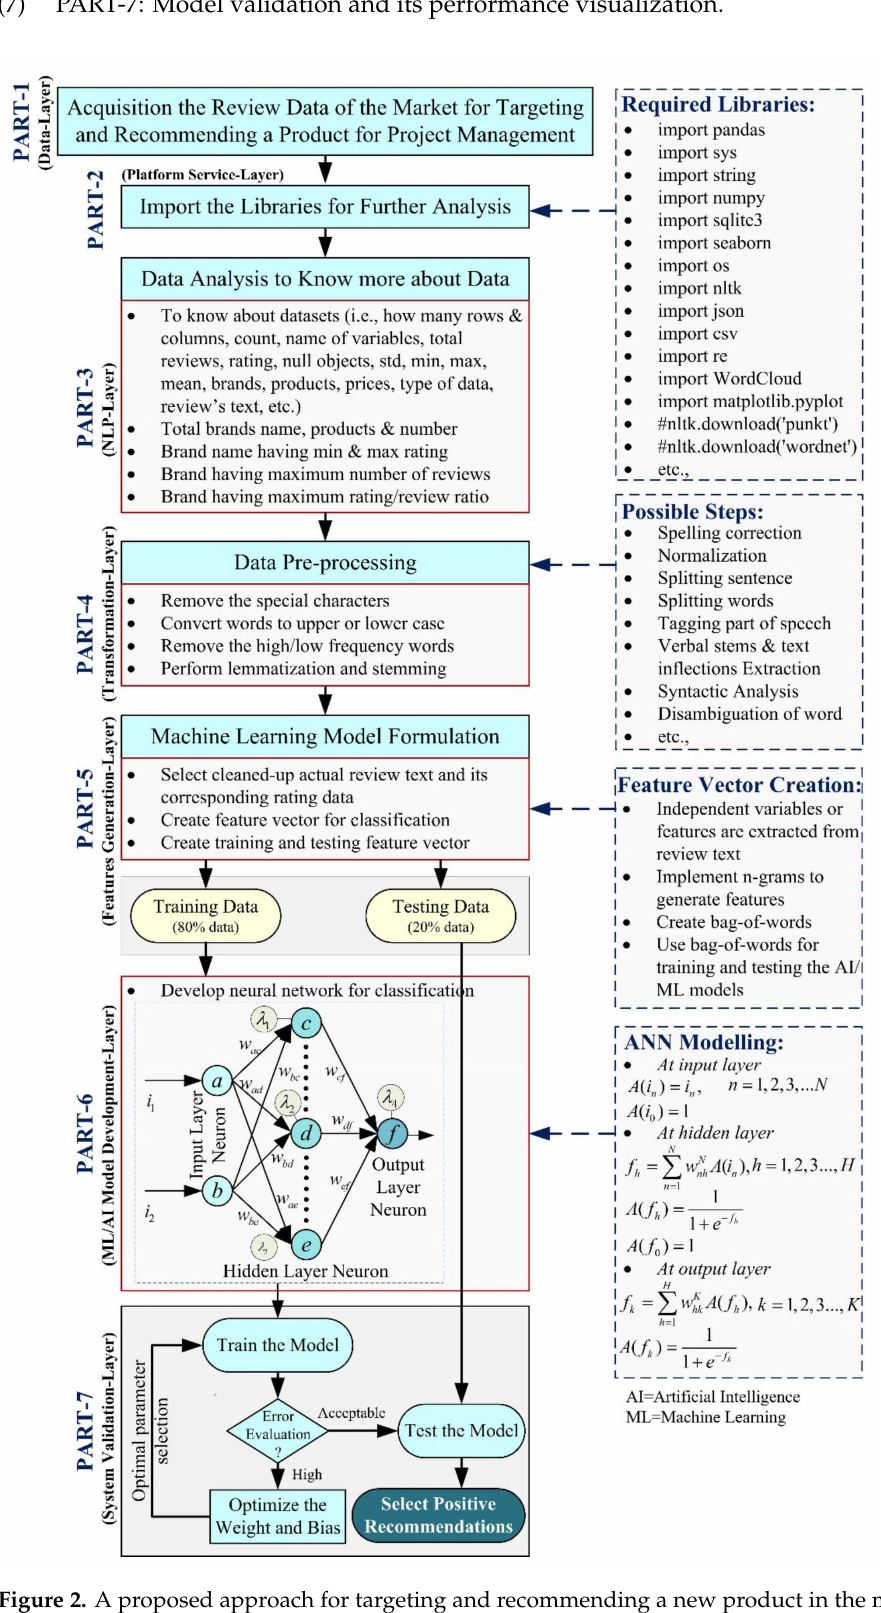
Figure 2. A proposed approach for targeting and recommending a new product in the market for project